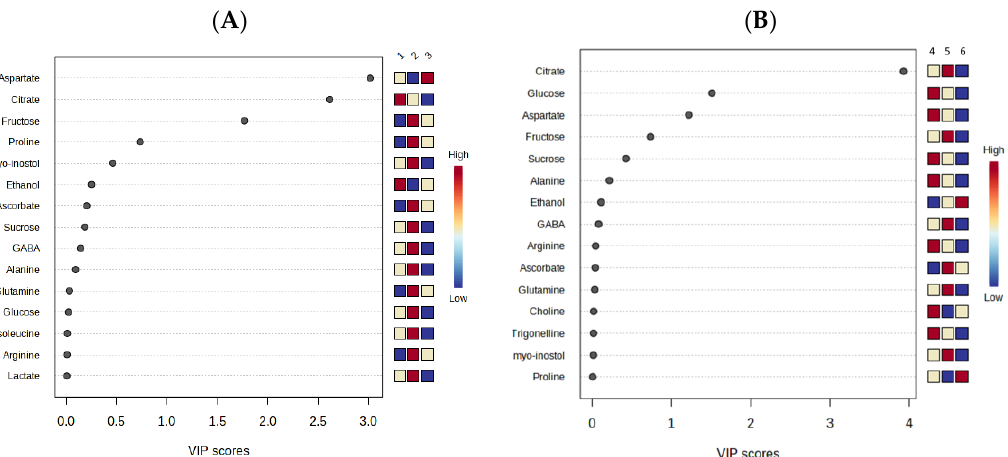
Figure 9. Graph of VIP scores (variable importance in projection), derived from the partial least squares discriminant analysis (PLS-DA), with the corresponding heat map where red and blue indicate the level of metabolites. The results are analyzed according to ( A ) the rootstock used ( n = 3) and ( B ) the substrate ( n = 3), where 1 to 3 corresponds to the rootstock type as (1) Citrus macrophylla ; (2) Citrus aurantium ; and (3) Citrus aurantium/Citrus sinensis ; and 4 to 6 is related to the culture media: (4) 75% peat + 25% port sediment; (5) 50% peat + 50% port sediment; and (6) 25% peat + 75% port sediment.